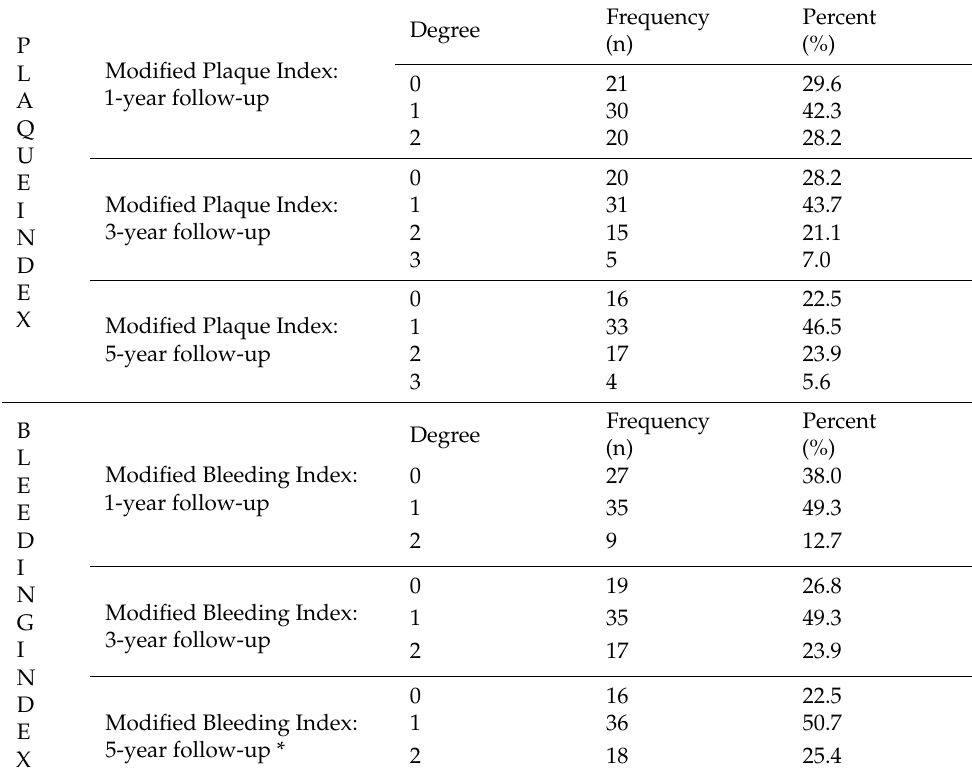
Table 4. Frequencies of modified plaque and bleeding indices over